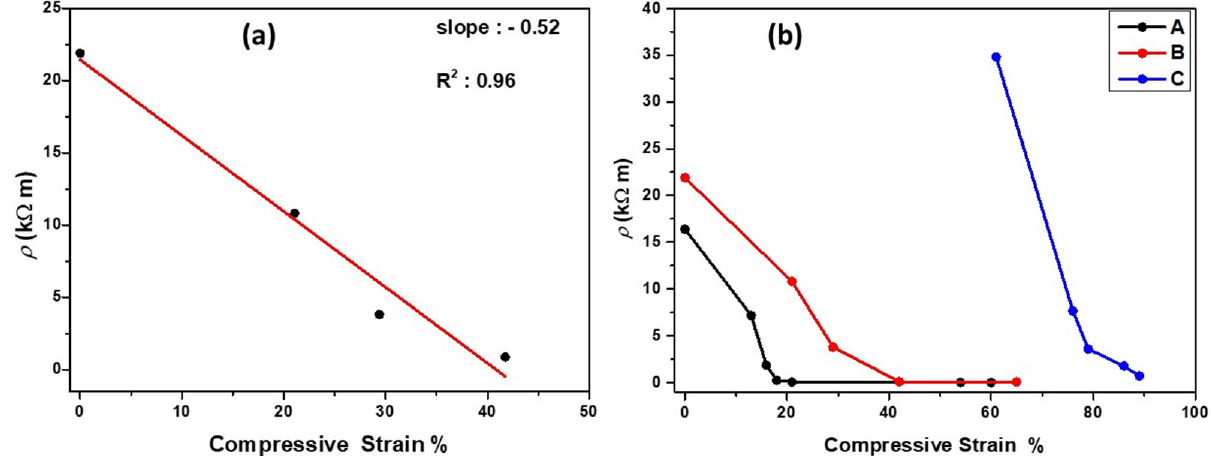
Figure 3. ( a ) Linear relationship between electrical resistivity and compressive strain of sample B. ( b ) The electrical resistivity of the doped MS samples versus compressive strain.